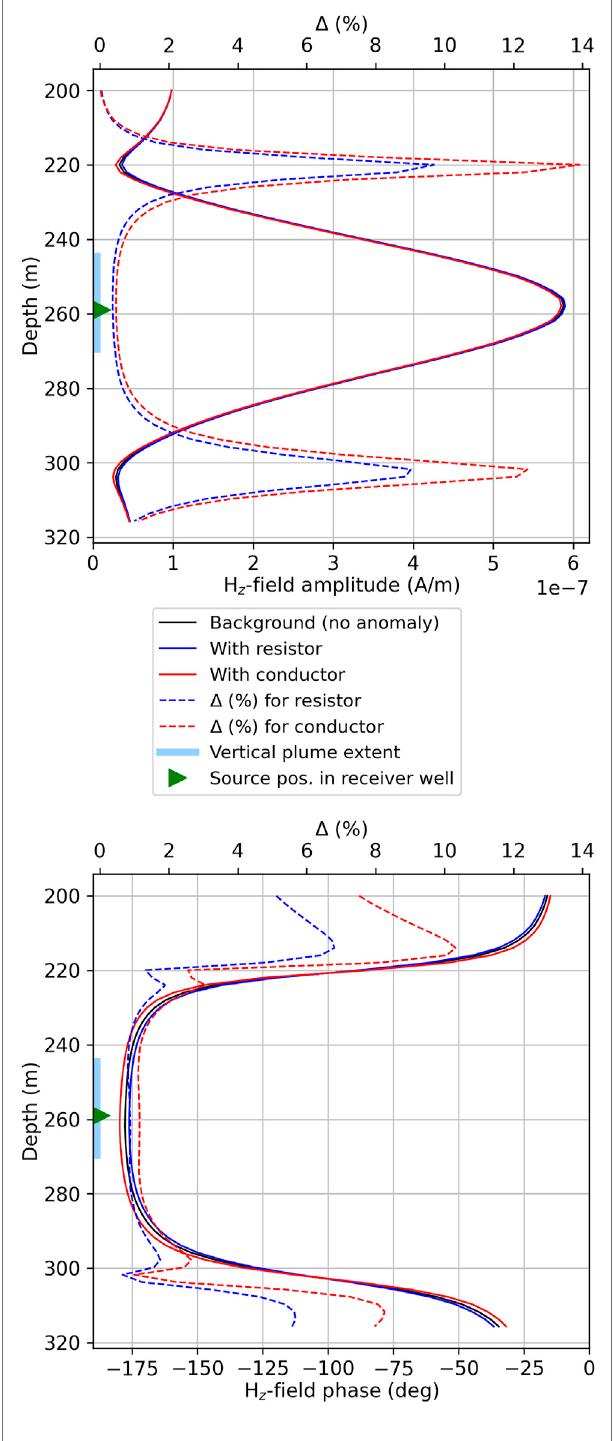
FIGURE 6 | Sensitivity check in form of background-versus-anomaly forward modeling. The shown pro fi le corresponds to one transmitter-receiver traverse. Hz- fi eld amplitudes resulting from the background model (black lines) are compared against their counterparts calculated from the models with resistive (blue lines) and conductive (red lines) bodies. Dashed lines show percentage differences.